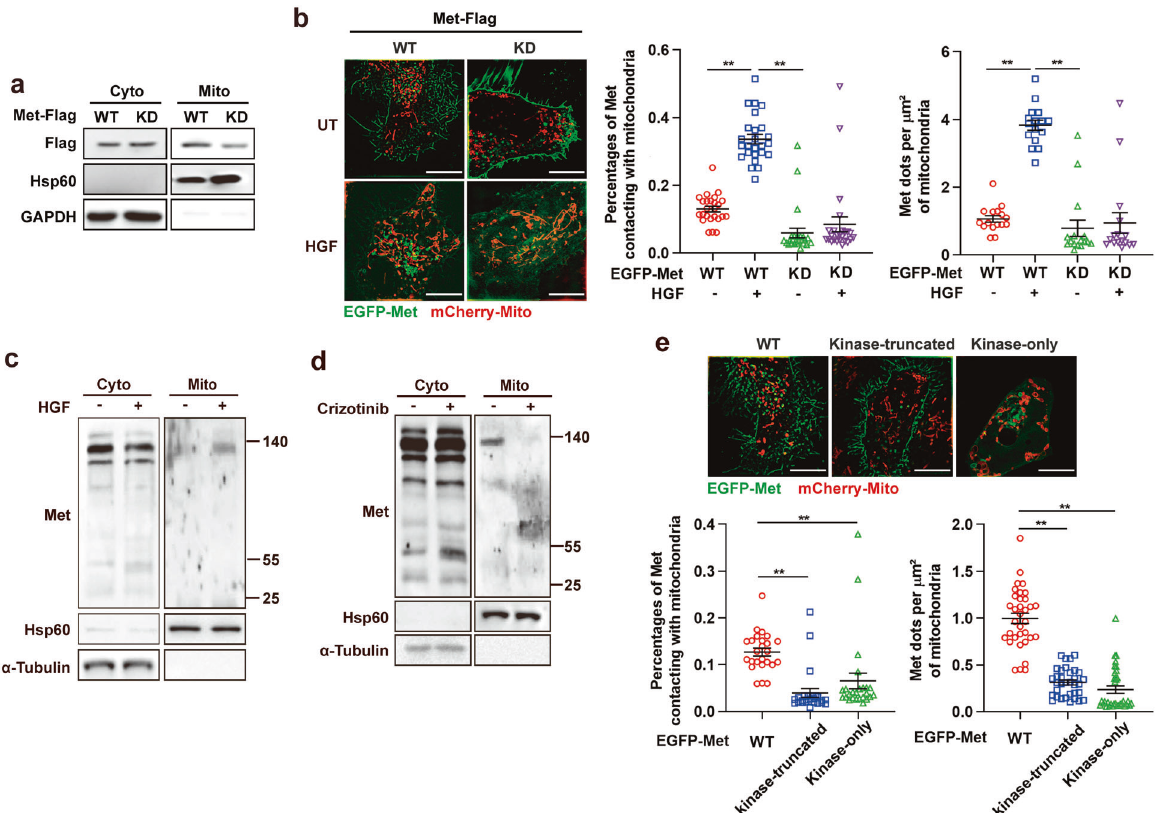
Fig. 2 Kinase activity is required for mitochondrial traf fi cking of Met. a Immunoblot analysis of Flag-Met in mitochondrial and cytosolic fractions of Met -/ − Huh7 cells stably transfected with WT Flag-Met and KD Flag-Met. Mitochondria isolation markers, GAPDH (cytoplasmic) and Hsp60 (mitochondria) were used as controls. b Met − / − HeLa cells stably expressing WT or KD EGFP – Met and mCherry – Mito were treated with HGF (100 ng/ml, 20 min) or not and then subjected to SIM live-cell imaging. Representative SIM images of mitochondrial localization of Met are shown. Scale bars, 10 µm. Quanti fi cation of percentages of Met contacting with mitochondria ( n = 25 fi elds) and the number of Met dots docking at per µm 2 of mitochondria ( n = 16 fi elds). Error bars represent means ± SEM (** p < 0.01; Student ’ s t test). c , d Immunoblot analysis of intact and fragmented Flag-Met in mitochondrial and cytosolic fractions of Huh7 cells treated with HGF (100 ng/ml, 20 min) ( c ) or crizotinib (1 µM, 1 h) ( d ). Mitochondria isolation markers, α -Tubulin (cytoplasmic) and Hsp60 (mitochondria) were used as controls. e Representative SIM live-cell imaging of mitochondrial localization of Met in Met − / − HeLa cells stably transfected with WT, kinase-truncated or kinase-only EGFP – Met. Scale bars, 10 µm. Quanti fi cation of percentages of Met contacting with mitochondria (n = 25 fi elds) and the number of Met dots docking at per µm 2 of mitochondria ( n = 34 fi elds). Error bars represent means ± SEM (** p < 0.01; Student ’ s t test)